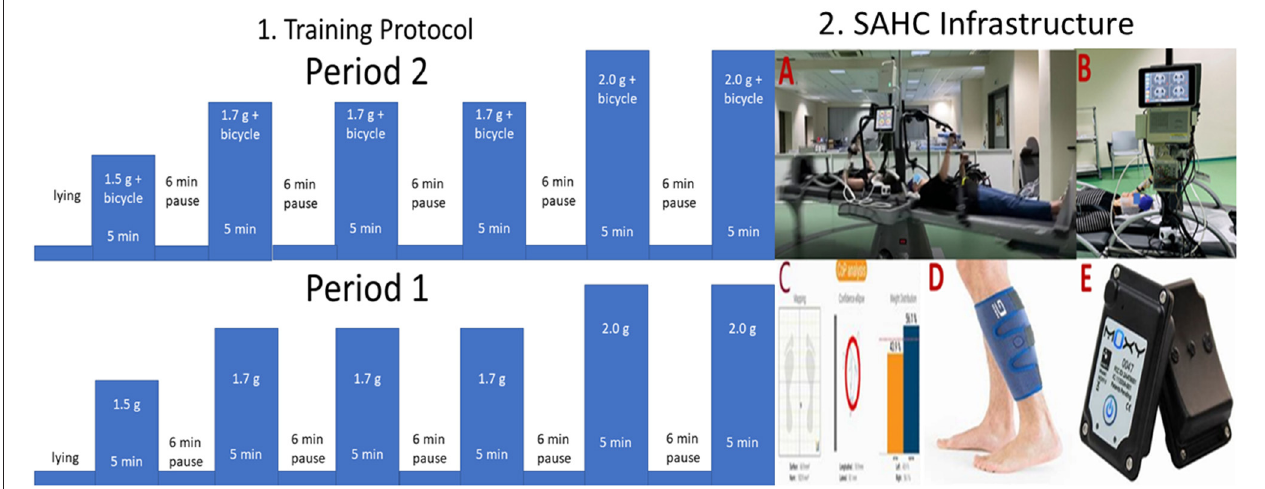
FIGURE 3 | 1. Visualization of the intervention protocol and 2. Visualization of the Short Arm Human Centrifuge (SAHC) infrastructure used for rehabilitation (A) . The infrastructure is equipped with two electroencephalographic (EEG) devices with 32 and 64 channels respectively for simultaneous neurophysiological data acquisition (B) . Cardiovascular biosignals were recorded every 30s through the Clear Sight device also depicted in B. Balance outcome metrics were extracted through the Kinvent device at pre/post-intervention intervals on a standing position (C) . Muscle oxygenation was recorded through a near-infrared spectroscopy device (D) , while the device is presented in (E)